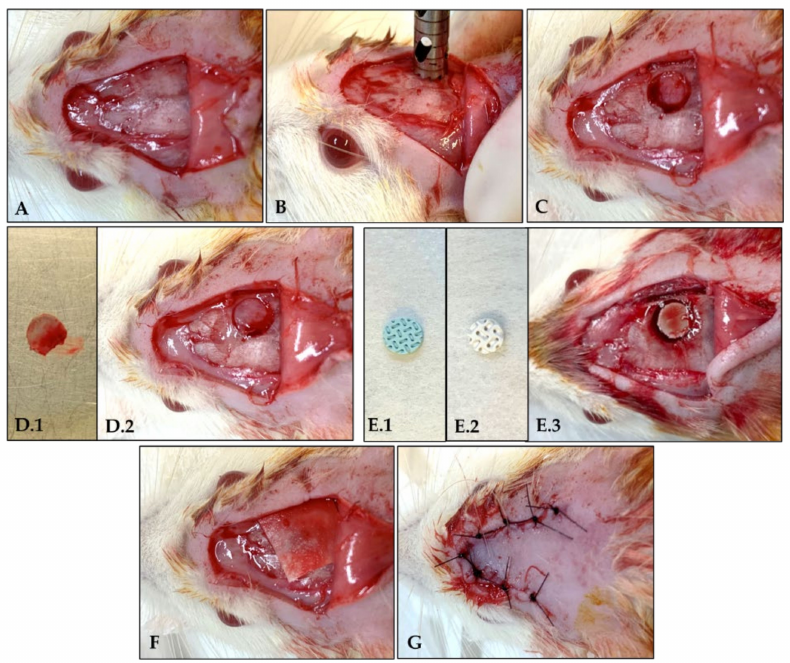
Figure 2. Surgical procedure for creating a critical defect in calvaria. ( A ): U-shaped incision; ( B ): 5 mm diameter inner drill bit positioning for defect creation; ( C ): Osteotomy and parietal bone remotion